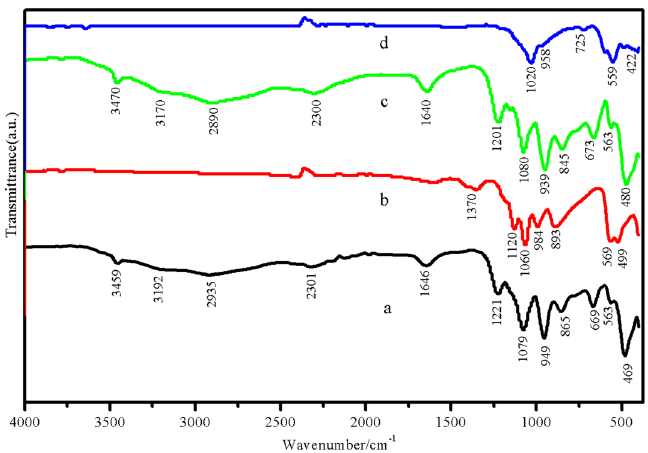
Figure 5. FTIR spectra of triple superphosphate (a), dicalcium phosphate dihydrate (b), monocalcium phosphate monohydrate (c), and tricalcium phosphate